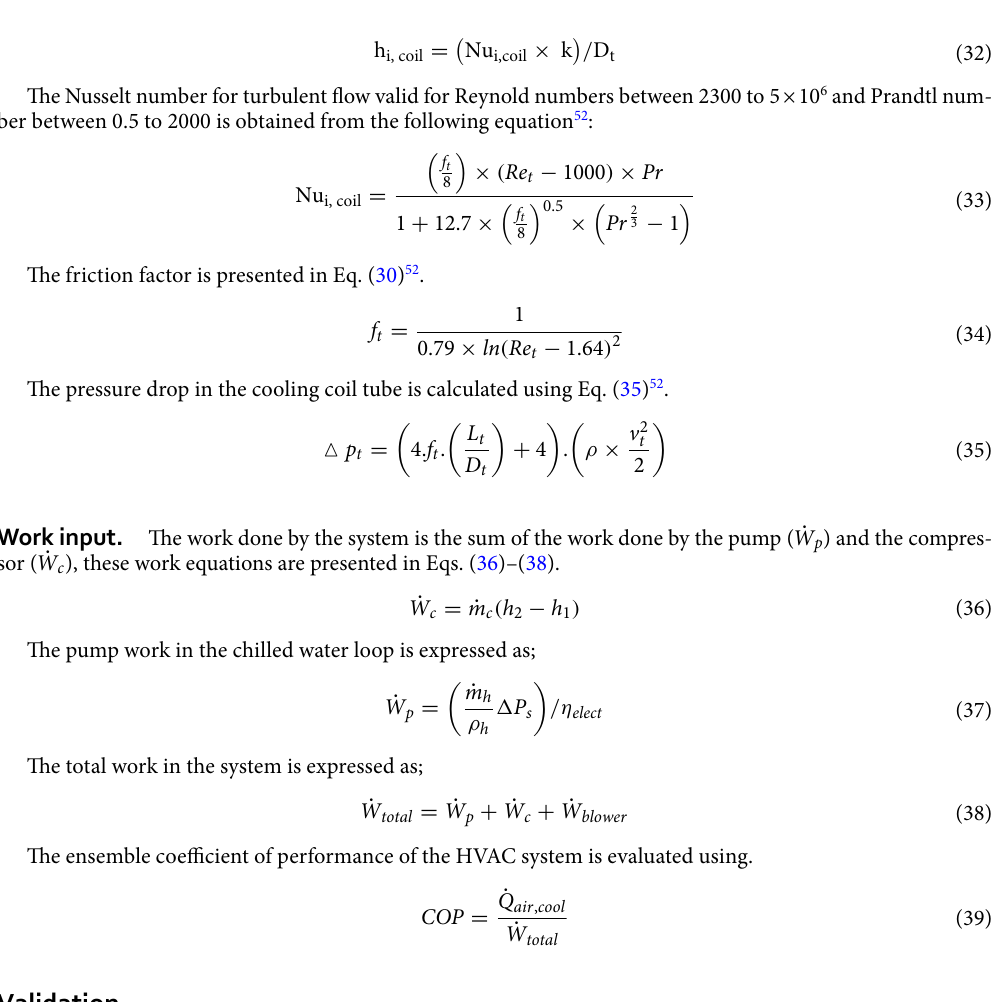
Figure 2. Accuracy of the model results compared to manufacturer